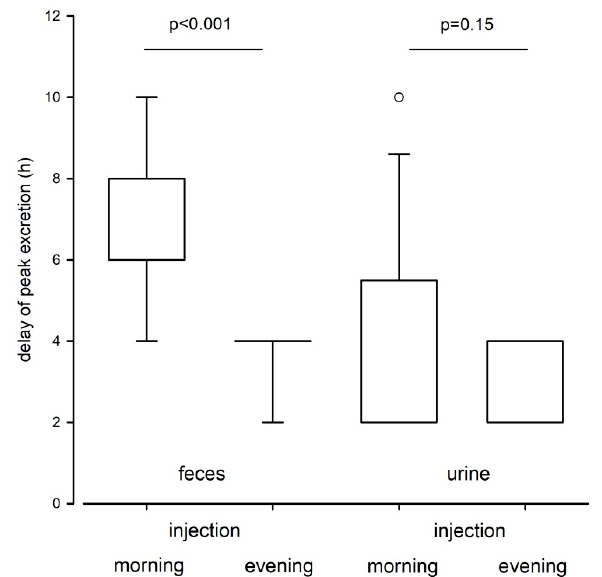
Figure 2. Delay time in hours to peak excretion in urinary and fecal samples of C57BL / 6J mice. Peak excretion times are depicted separately for the morning (n = 16) and evening (n = 16) injection group. Mice from the morning group received the 3 H-testosterone one hour after the onset of the light phase, whereas mice from the evening group received the 3 H-testosterone one hour after the onset of the dark phase. Dots are outliers with values between 1.5-3.0 × interquartile range.